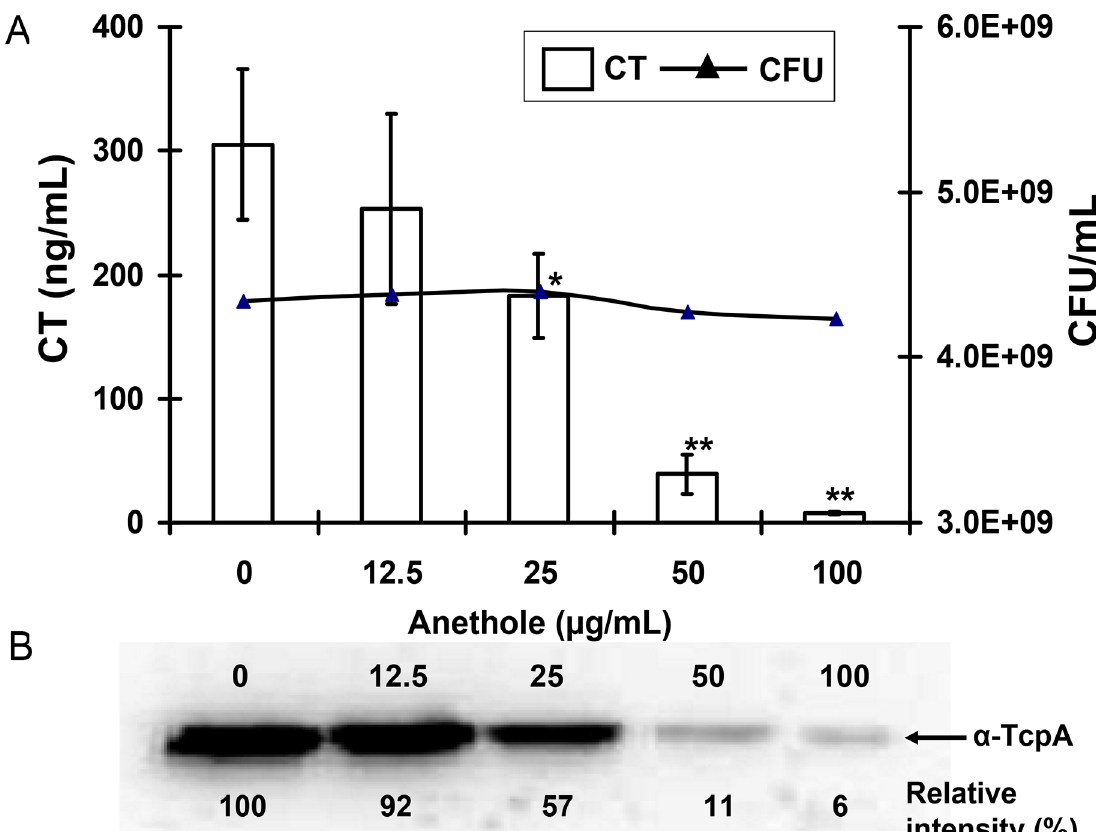
Fig 2. Dose-dependent inhibitory effects of anethole on CT and TCP production in V . cholerae O1 El Tor variant strain CRC41. (A) Effects of anethole on CT production and bacterial viability presented in the primary and secondary y-axis , respectively. x-axis indicates the concentrations of anethole used in these assays. Data are presented as the averages ± SD of three independent observations. By using two sample t -test, a single asterisk ( * ) represents p < 0.05 and two asterisks ( ** ) represents p < 0.01 as compared with the anethole-free culture. (B) Dose-dependent effect of anethole on TcpA expression. Three independent experiments were conducted and a representative western blot image is shown here. The band signal intensities (shown below the image) of the image of western blot were quantified by ImageJ software (http://imagej.nih.gov/ij/), and normalized to that of without anethole sample (arbitrarily taken as